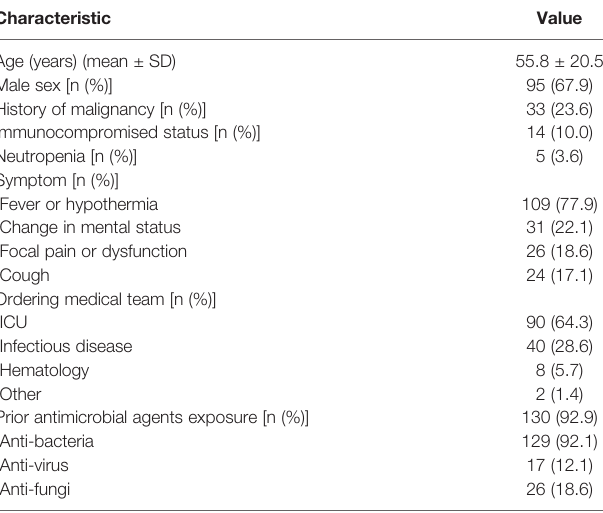
TABLE 1 | Demographic and Clinical Characteristics of the 140 Patients.